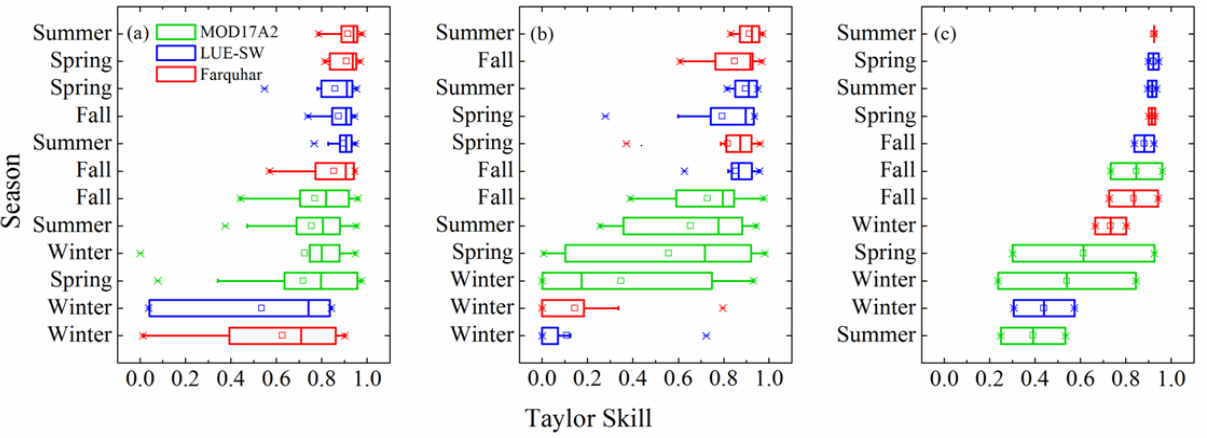
Figure 3. Boxplots of Taylor skill ( S ) for daily GPP by models and seasons across ( a ) evergreen forests, ( b ) deciduous forests and shrubs, and ( c ) grasslands. Panels show the interquartile range (box), mean (square), median (solid line), range (whiskers), and outliers (cross). The models and seasons are sorted by the median Taylor